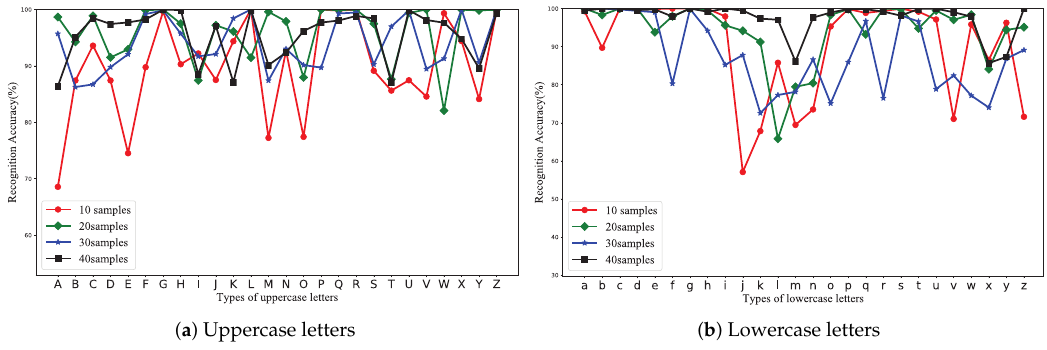
Figure 10. The impact of the number of samples on the accuracy of 52 classes